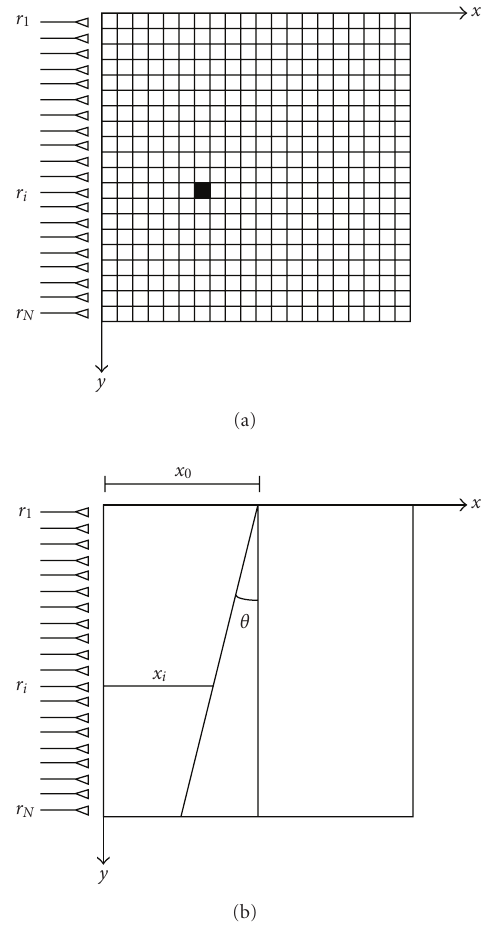
Figure 1: image data